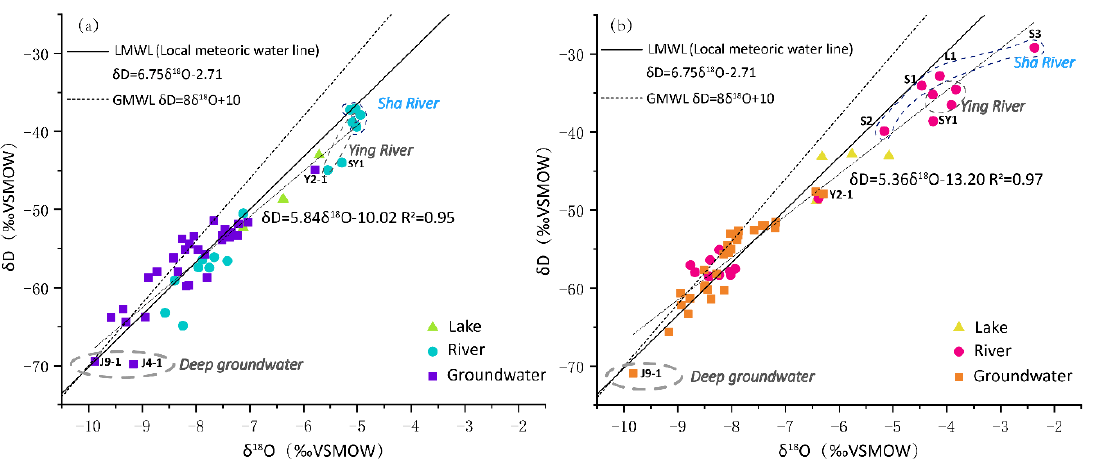
Figure 9. Plot of δ 18 O and δ D of various water samples from Shaying River Basin in the dry season ( a ) and wet season ( b ).